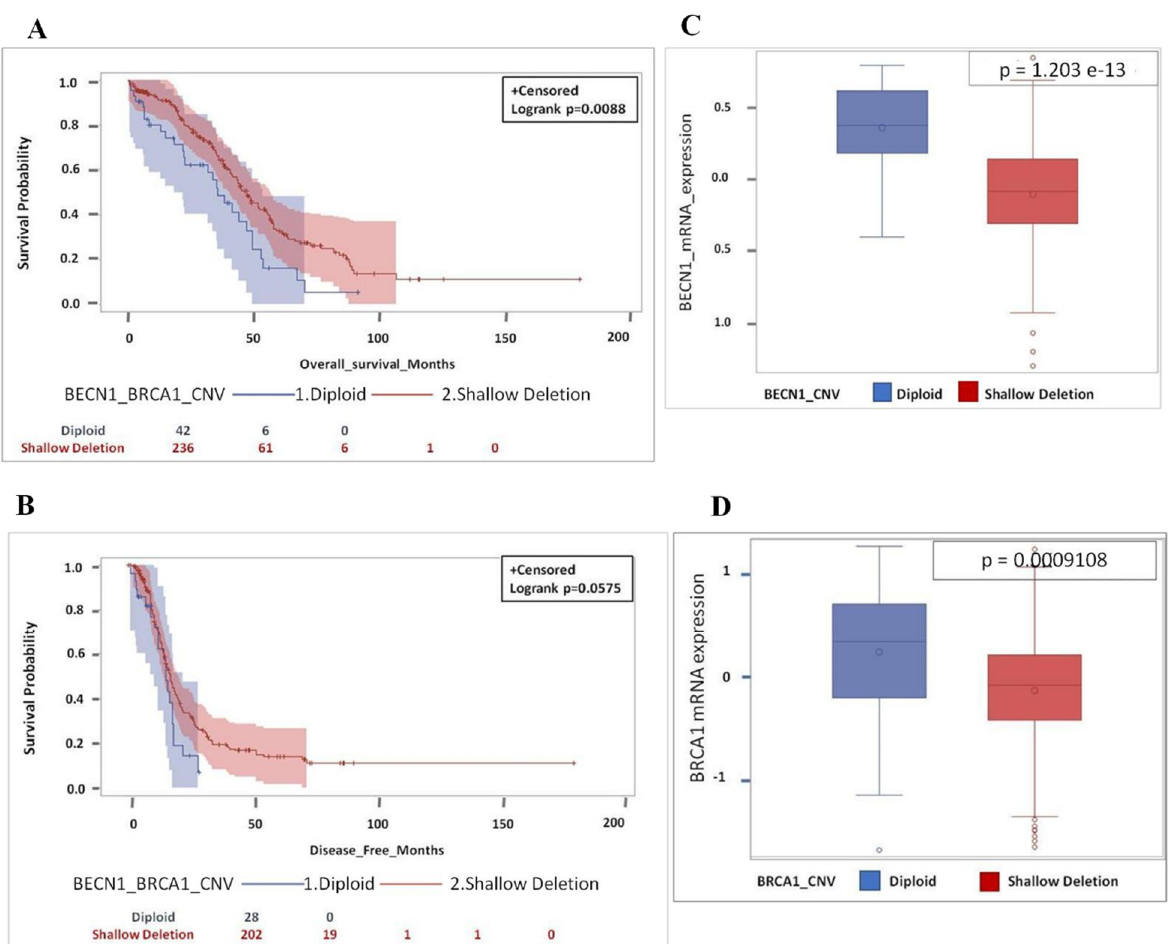
Figure 5. Shallow deletion of BECN1 and BRCA1 with low mRNA expression in TP53 -mutated patients is associated with better overall survival as well as disease-free survival. ( A ) Overall survival for HGSOC patients based on BECN1 and BRCA1 CNV. ( B ) Disease-free survival for HGSOC patients based on BECN1 and BRCA1 CNV. ( C ) Box-plot showing the distribution of BECN1 expression according to CNV. ( D ) Box-plot showing the distribution of BRCA1 expression according to CNV. (Note that for OS data were not available for 1 patient (diploid group 1 pt: 42 pt’s; diploid group total n =43 pt’s) while for DFS data were missing for 49 patients (diploid group 15 pt’s : 28 pt’s + shallow deletion group 34 pt’s : 202 pt’s; total n =279 pt’s), respectively).